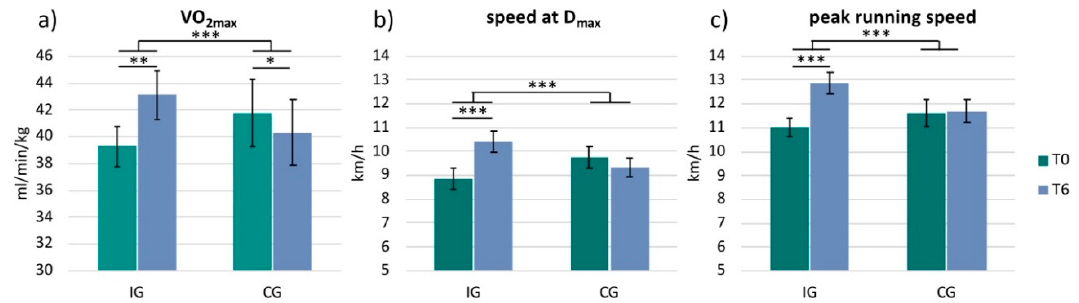
Figure 2. Physiological parameters. Bar plots show the physiological parameters for each group (IG = intervention group and CG = control group) and for each timepoint (T0 and T6): ( a ) VO 2max ; ( b ) speed at D max ; ( c ) peak running speed; *** p < 0.001, ** p < 0.01, * p < 0.05.